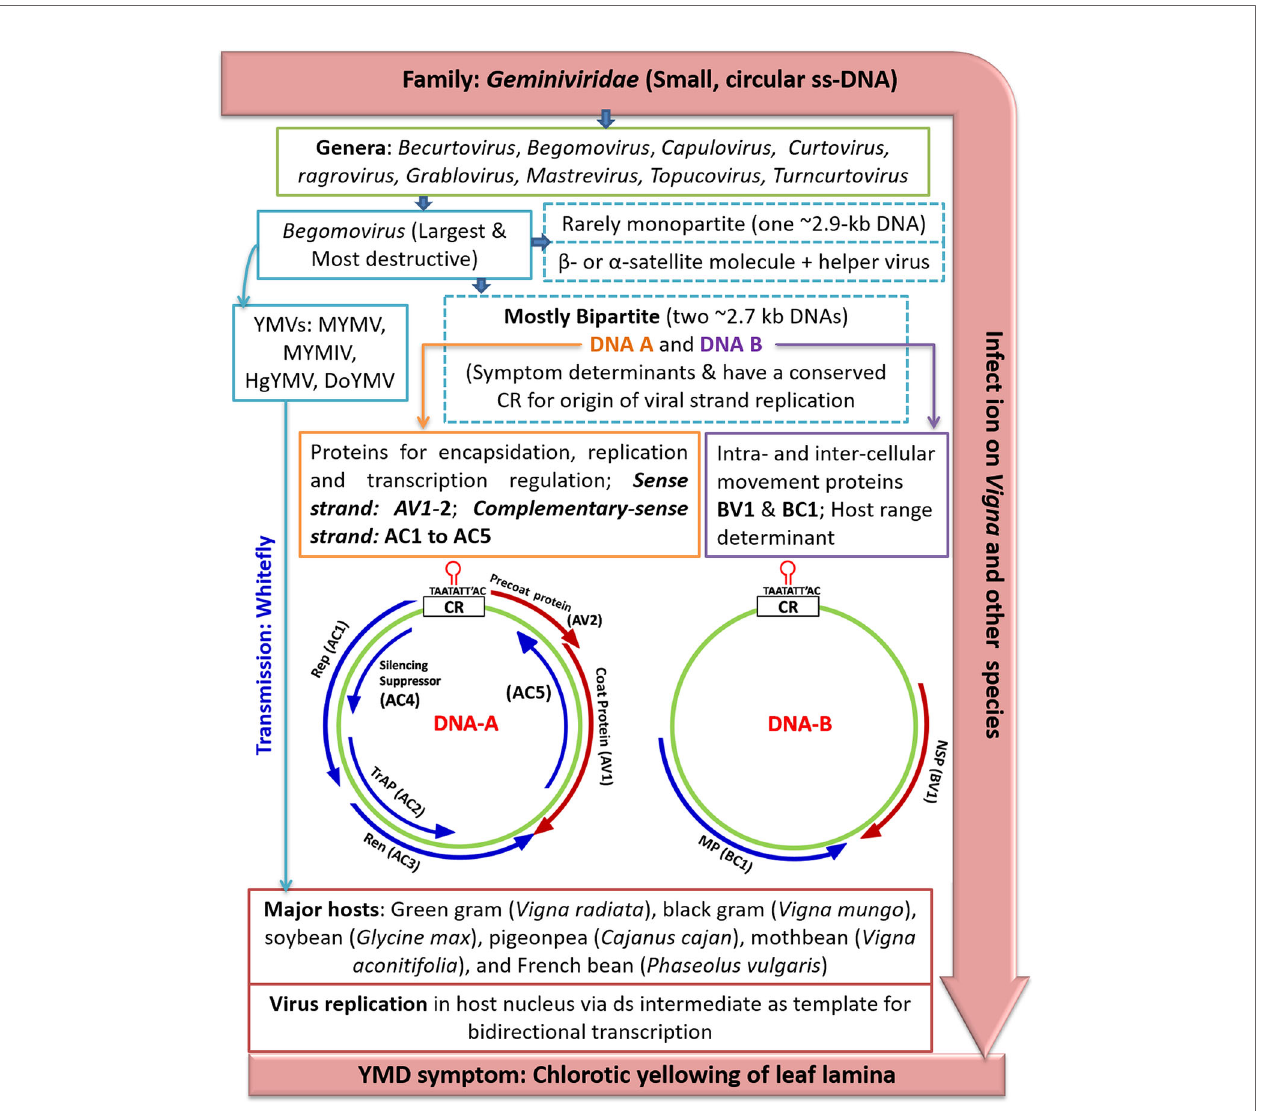
FIGURE 3 | An outline of YMD development in mungbean. Where, YMD (yellow mosaic disease), MYMV (mungbean yellow mosaic virus), MYMIV (mungbean yellow mosaic India virus), HgYMV (horsegram yellow mosaic virus), DoYMV (dolichos yellow mosaic virus), AV2 (precoat protein), CP/AV1 (coat protein), Rep/AC1 (replication protein), TrAP/AC2 (transcriptional activator protein), REn/AC3 (rep enhancer protein), AC4 (silencing suppressor), CR (common region). The maps of YMV genomic DNA-A and DNA-B components are derived from Kumar et al. (2017b) and Shivaprasad et al. (2005) in which the ORF (open reading frames) are presented as bar arrows with the head representing 3 ′